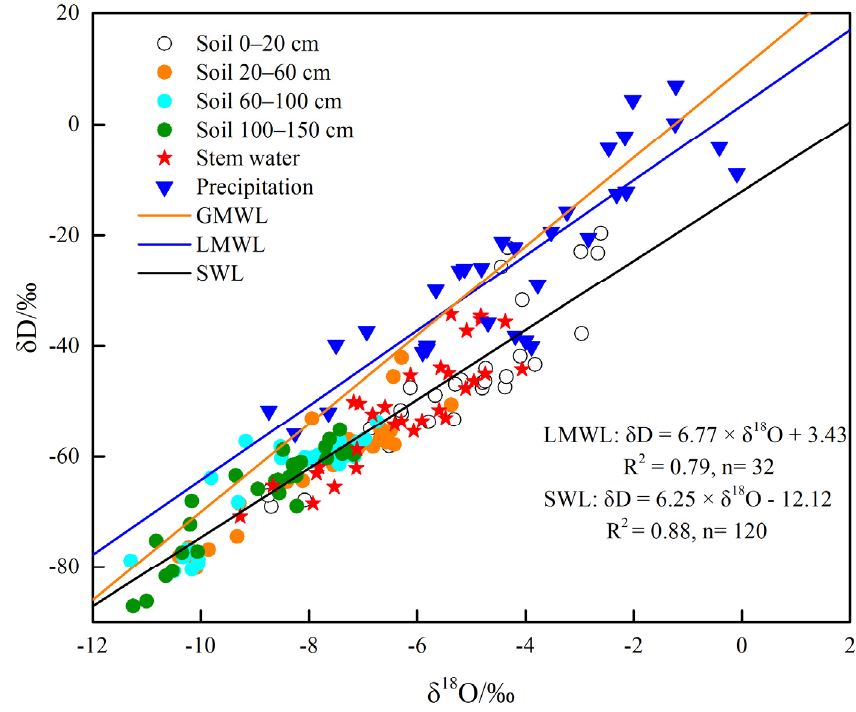
Figure 4. δ D- δ 18 O relationships for the water samples, local meteoric water line (LMWL) and soil water evaporation line (SWL).